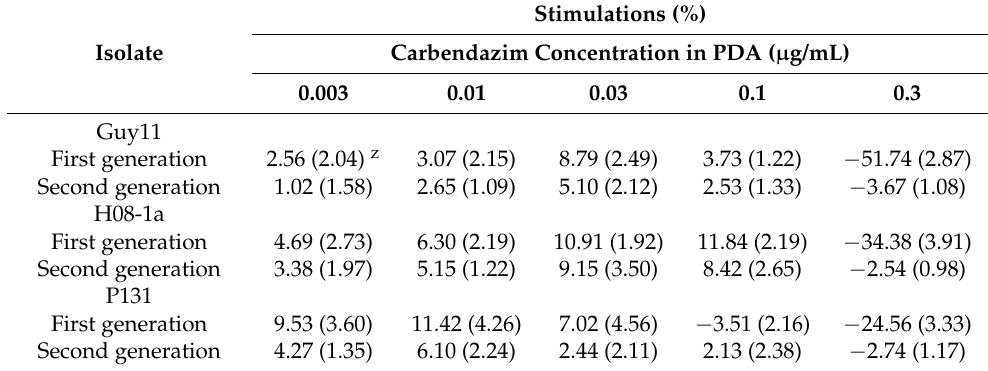
Table 2. Percent stimulations of carbendazim in PDA for the first- and second-generation mycelial growth.